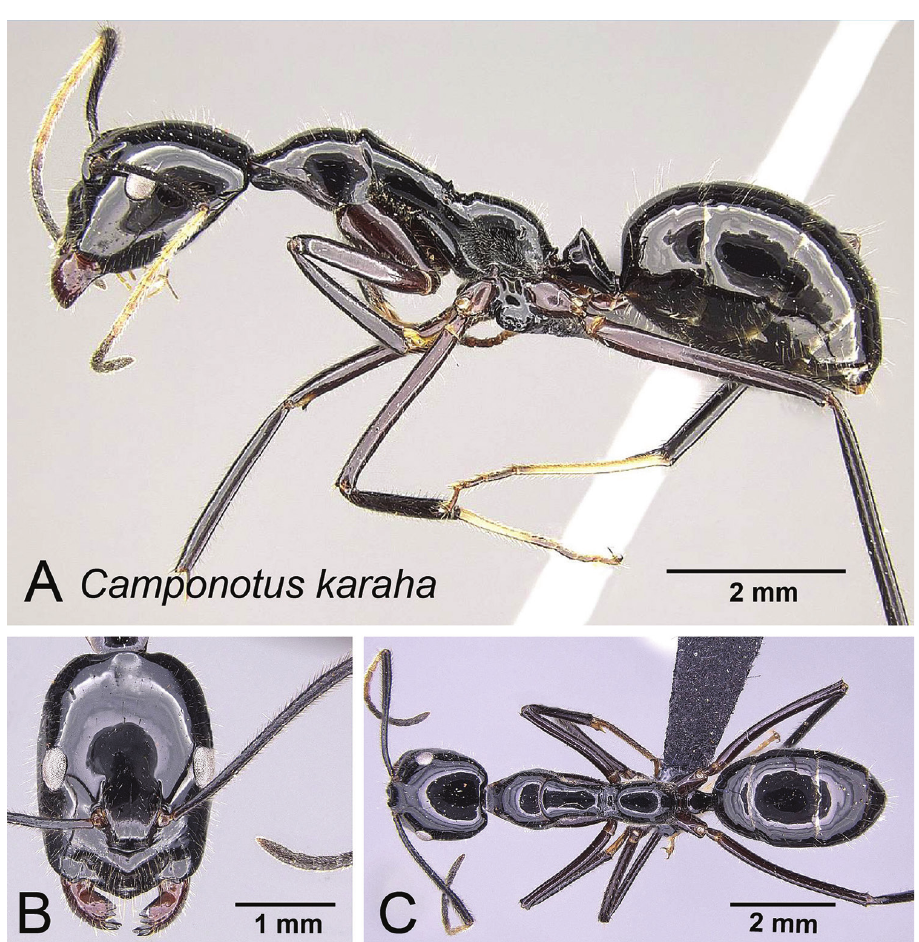
Figure 14. Camponotus karaha major worker CASENT0151921. A Lateral view B Head in full-face view C Dorsal